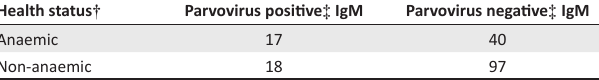
TABLE 1: Comparison of human parvovirus B19 infection among anaemic and non-anaemic children, Ilorin, Nigeria, November 2014–December 2015 ( N =